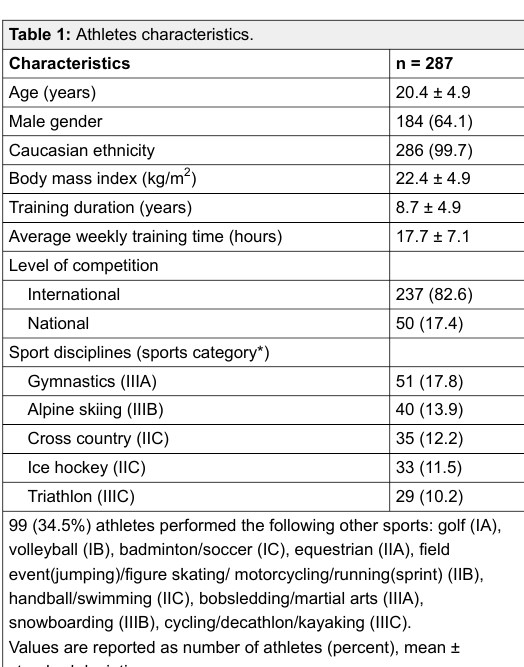
Allocation of ECG changes according to the original and revised Seattle criteria.